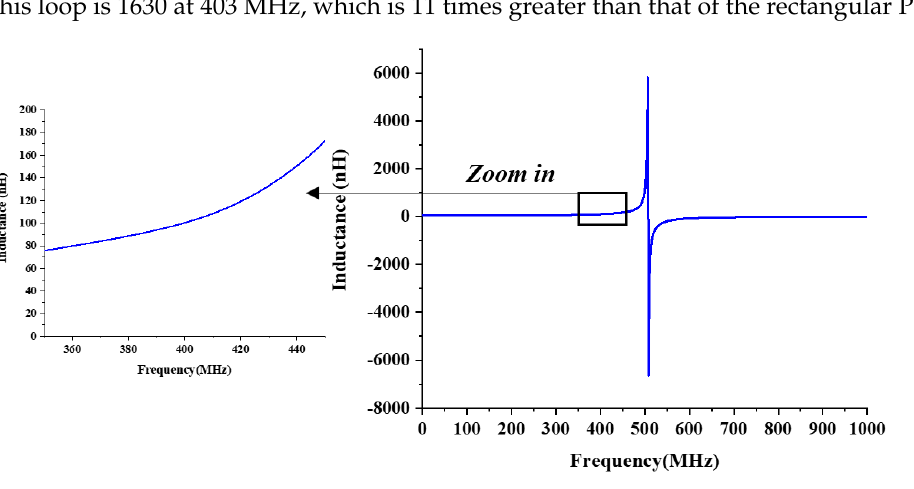
Figure 7. Simulated inductance of the optimised four-turn split-ring loop.